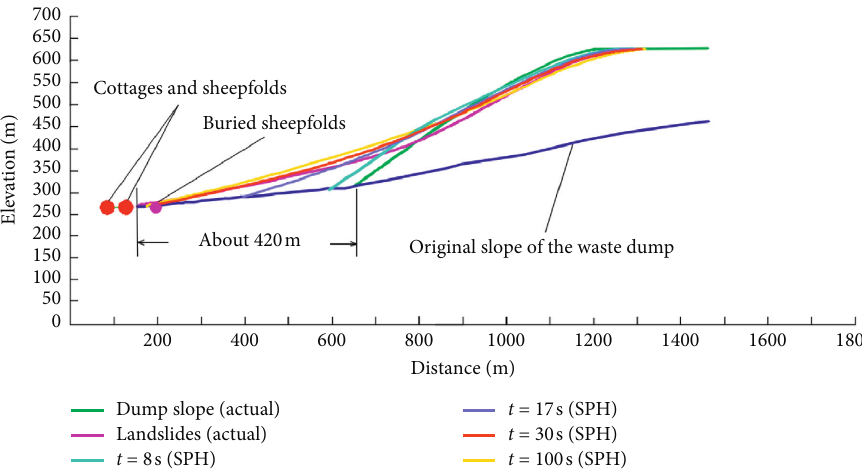
Figure 16: Comparison of the surveyed data and the SPH simulation for the full high waste dump